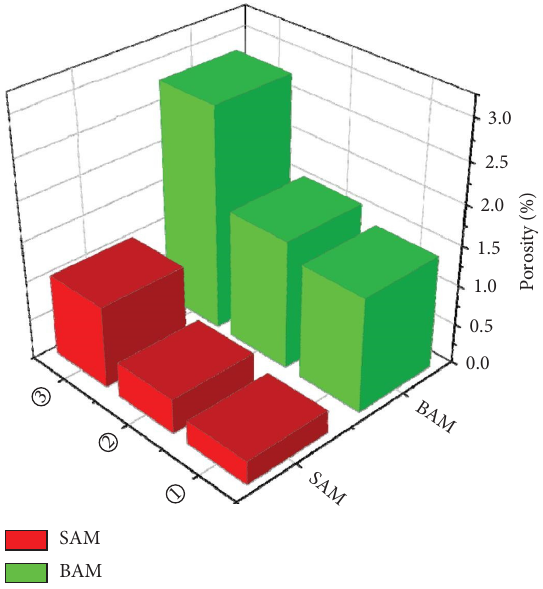
Figure 4: Te total porosity of SAM and